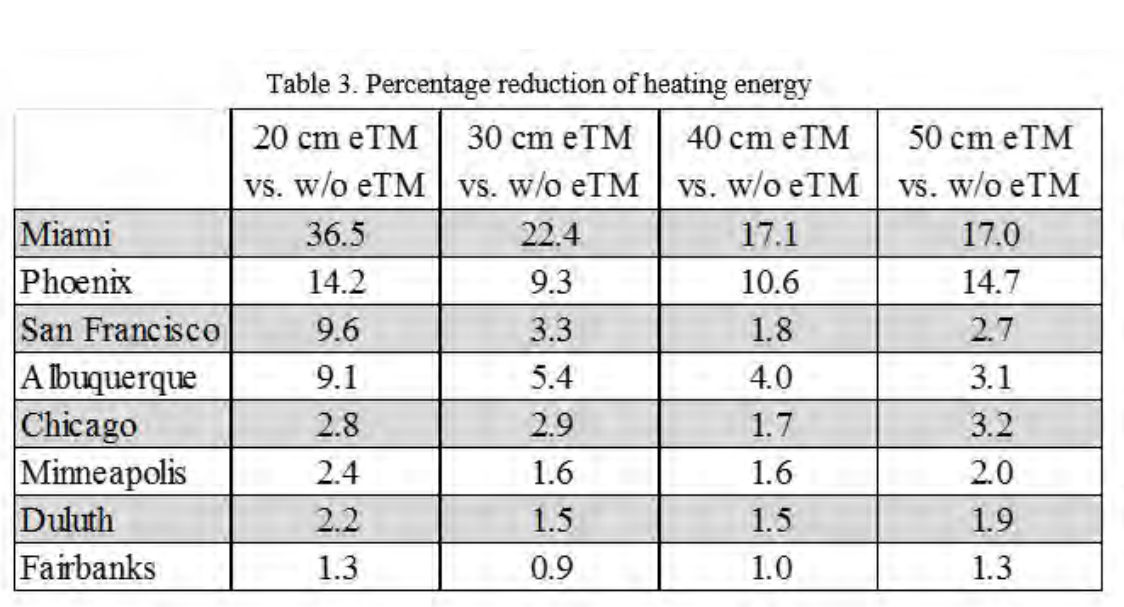
Figure 1. Heating energy